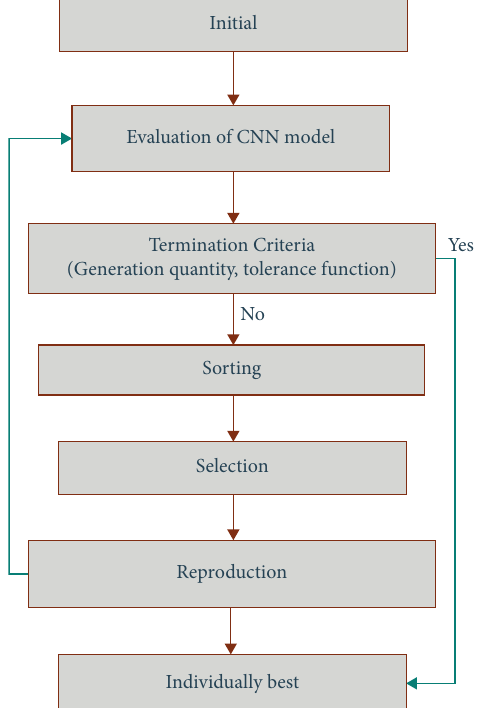
Figure 8: Flowchart of genetic algorithm process.